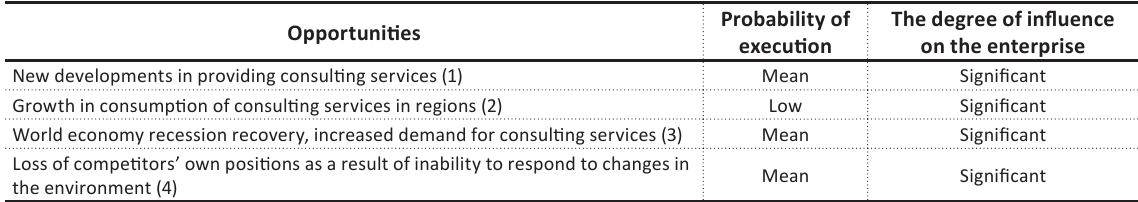
Table 4. Sigma Software opportunity matrix in the international market